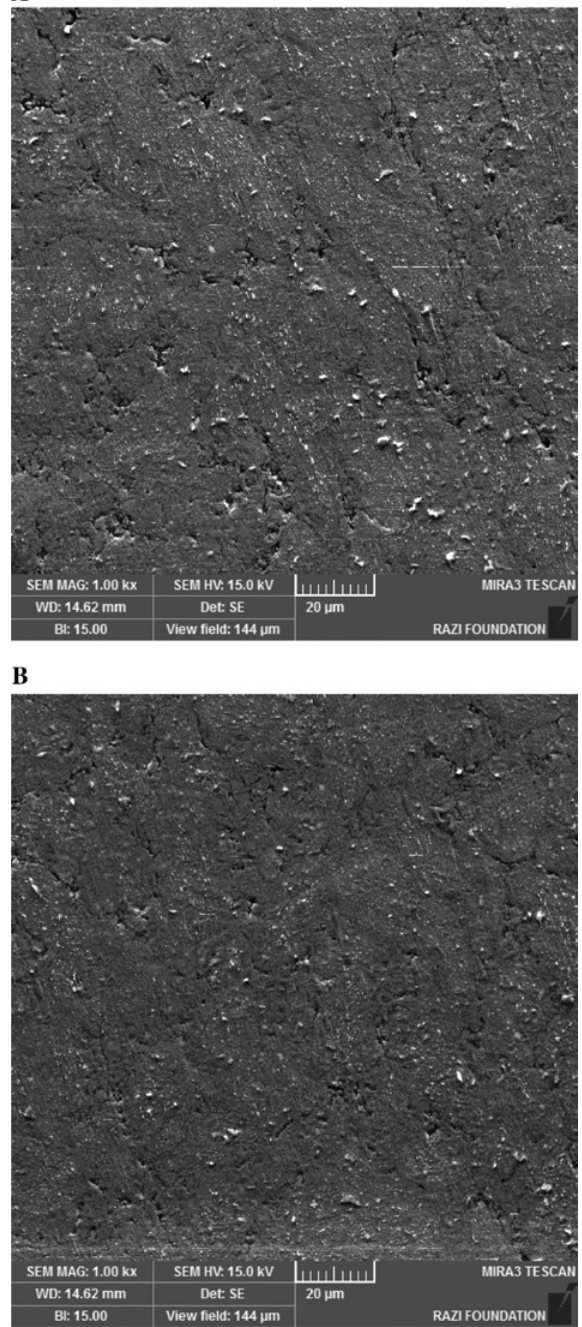
Figure 6: SEM images of cross-sectional microstructures sintered